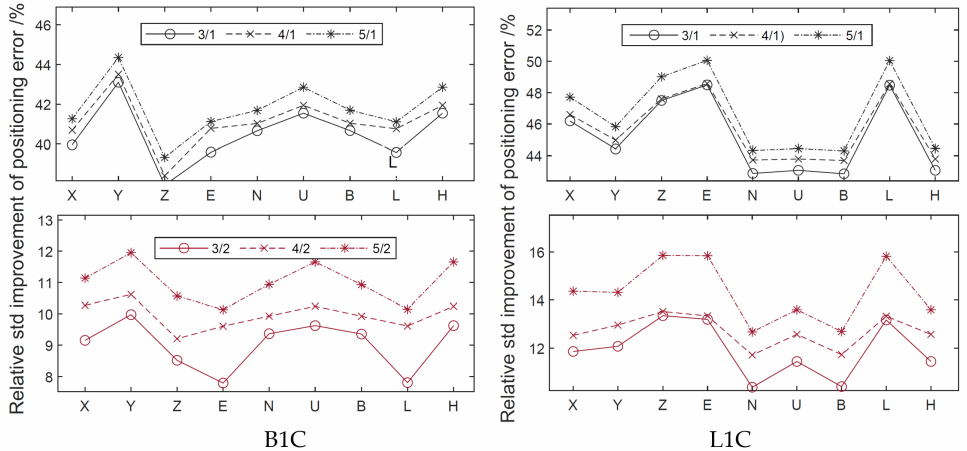
Figure 16. The relative improvement in the positioning accuracy coordinate